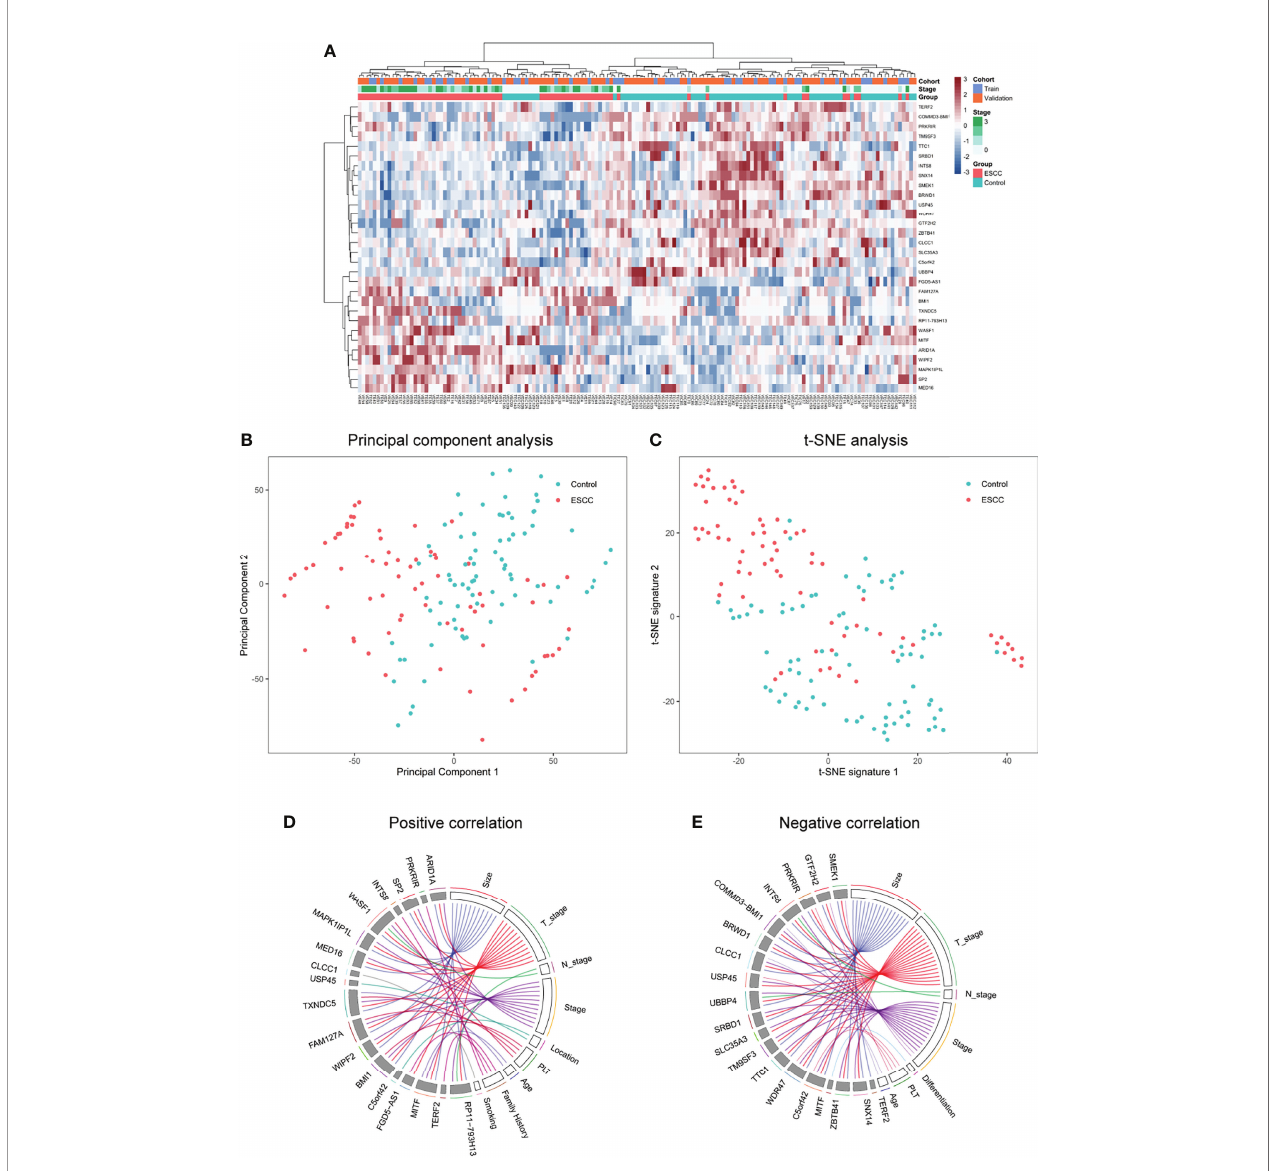
FIGURE 3 | Top 30 gene signatures and clinicopathological relevance selected by MRMR approach. (A) Unsupervised hierarchical clustering of diagnostic top- ranked 30 gene signatures effectively discriminated between the ESCC group ( n = 71) and the control group ( n = 80). The 30-gene signature enables non-random clustering of all samples ( p < 0.001, Fisher ’ s exact test). (B) Obviously different distributions of principal components analysis (PCA) between the control and ESCC group. Values of principal components were calculated using prcomp package in Rstudio. (C) Obviously different distributions of t-SNE visualization between the ESCC and control group. Values of t-SNE signature were calculated using Rtsne package in Rstudio. (D) Positive and (E) negative correlations between the diagnostic genes and clinical data. p -value above 0.05 was identi fi ed signi fi cantly correlated based on Pearson method between continuous data and Spearman method if one of the variables was not. Plots were drawn using the RCircos package in Rstudio. ESCC, esophageal squamous cell carcinoma; PCA, principal components analysis; t-SNE, t-distributed stochastic neighbor